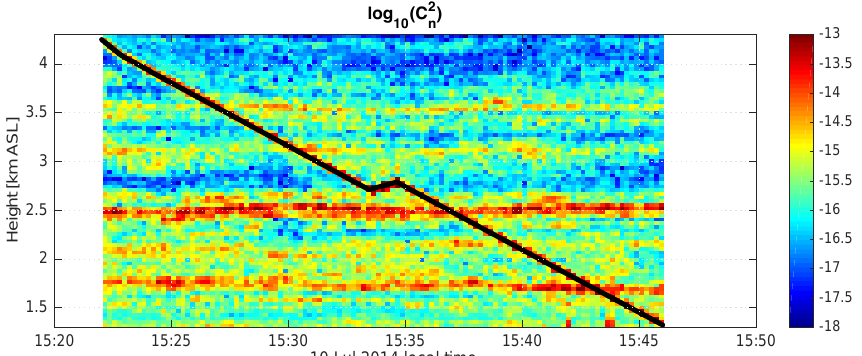
Figure 11. Similar to Fig. 5 but during the afternoon flight (15:21–15:46). In this case, the DataHawk was dropped by a “free” balloon at an altitude of approximately 8km. However, due to the strong winds, the DataHawk was advected 4km from the SOUSY radar, which caused a 3km drop during the time it took to regain its position over the